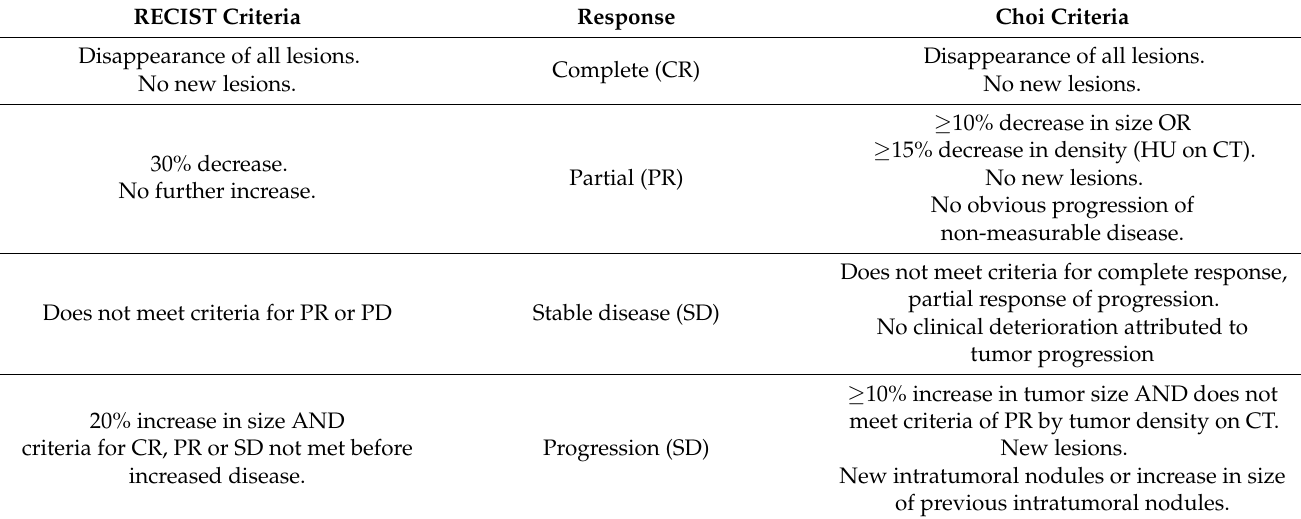
Table 1. Comparison of response criteria for